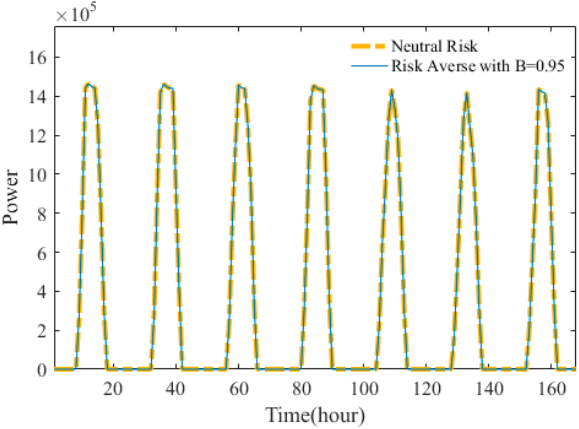
Figure 14. Transferred power from the PV to the demand side.